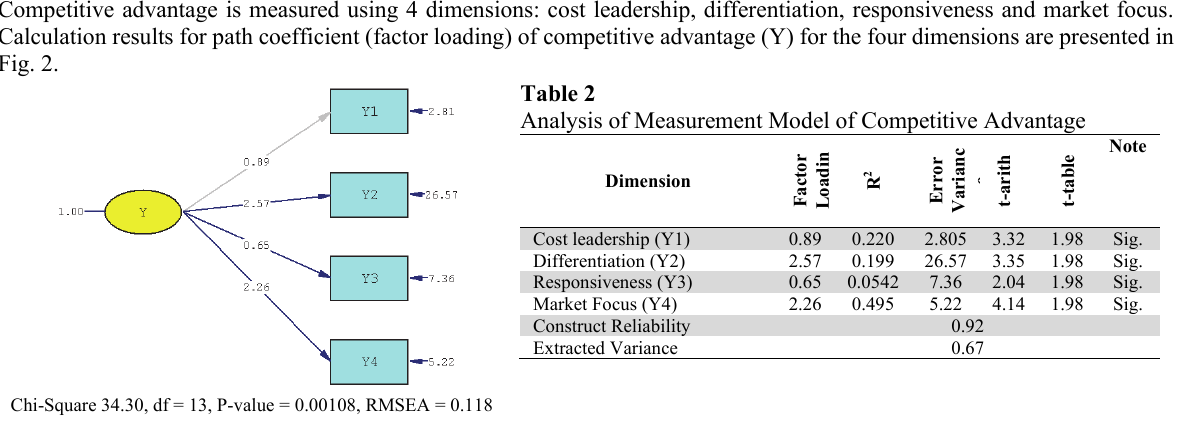
Fig. 2. Model of Competitive Advantage Measurement (Standardized Coefficient)